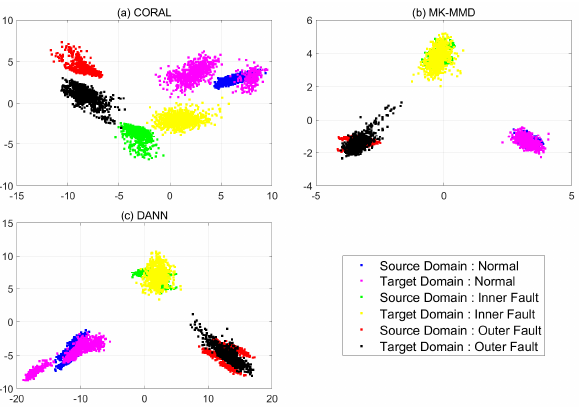
Figure 14. PCA results of case 3: ( a ) CORAL ( b ) MK-MMD ( c )